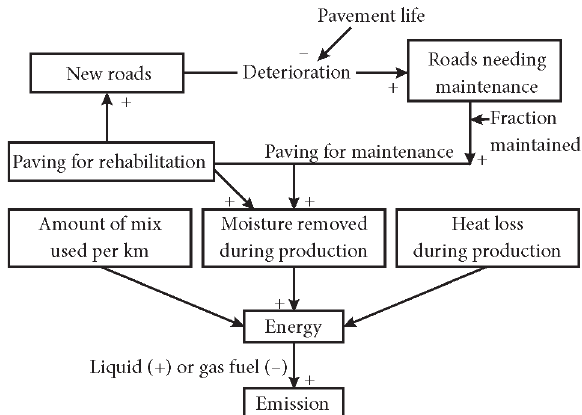
Fig. 2. Model for analysis of impact of road construction on the